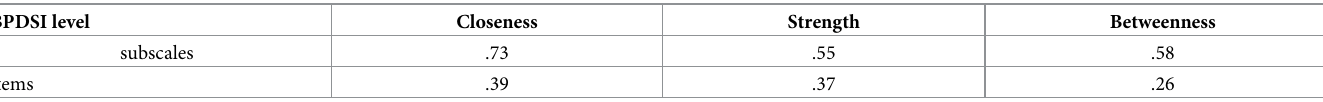
Table 1. Correlations between centrality parameters and random slope correlations by BPDSI level. BPDSI level Closeness Strength Betweenness subscales